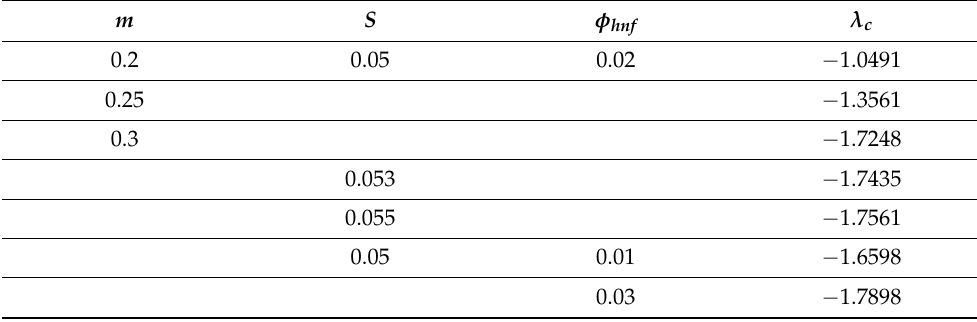
Table 4. Summary of the critical values with different physical parameters.